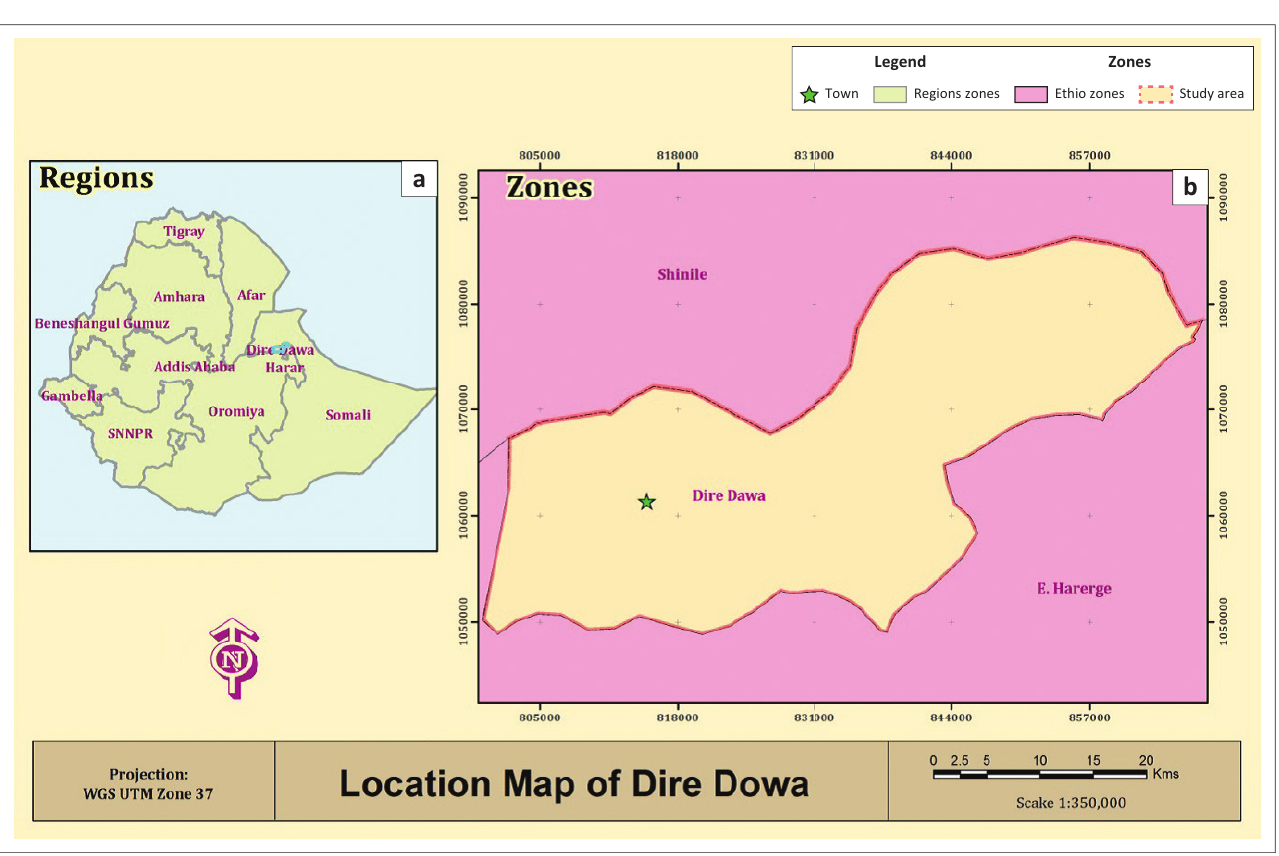
FIGURE 2: (a & b) Location of Dire Dawa city.